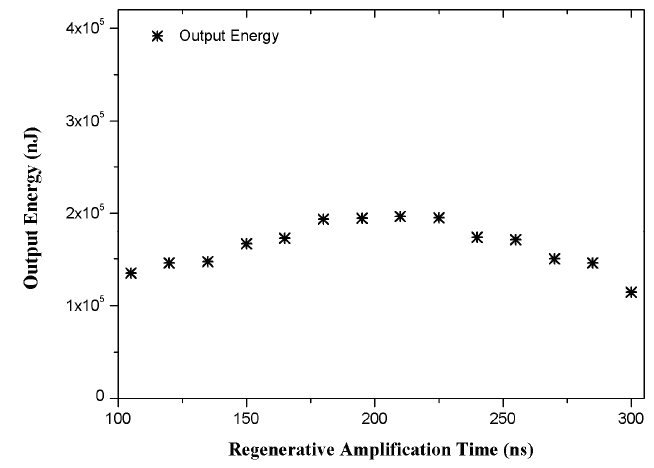
Figure 4. The output energy as a function of regeneration amplification time in